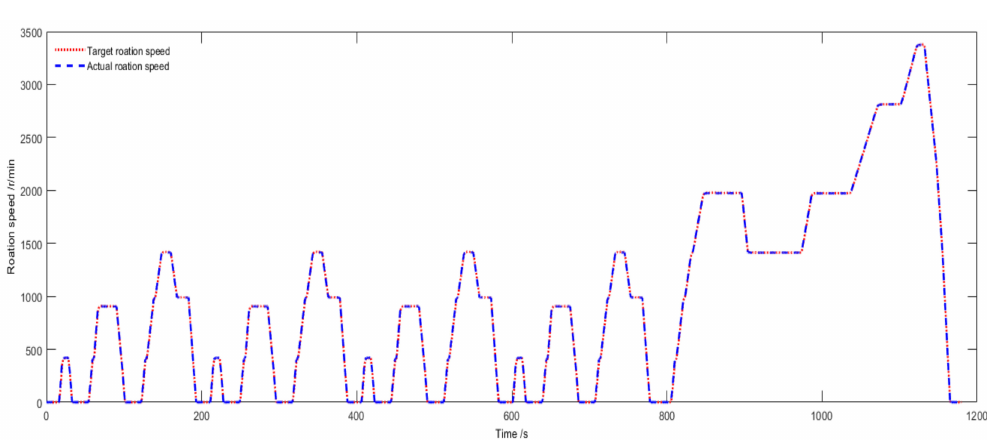
Figure 10. The target rotation speed and actual rotation